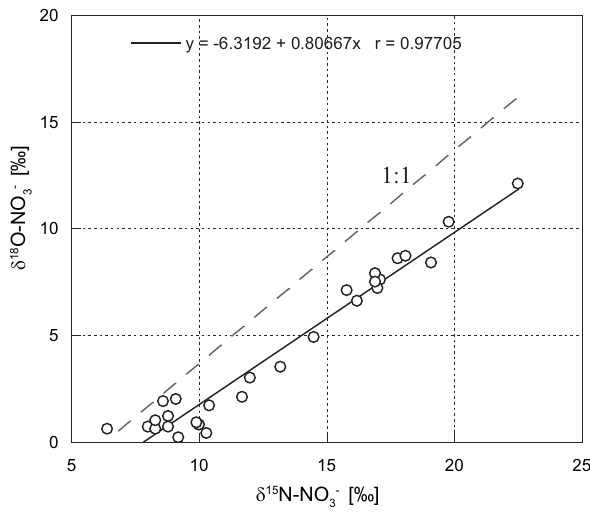
and δ 18 O − NO − to ex- 3 3 Fig. 4. δ 15 DON+NH + Figure 4 Geesthacht, June 2006–December